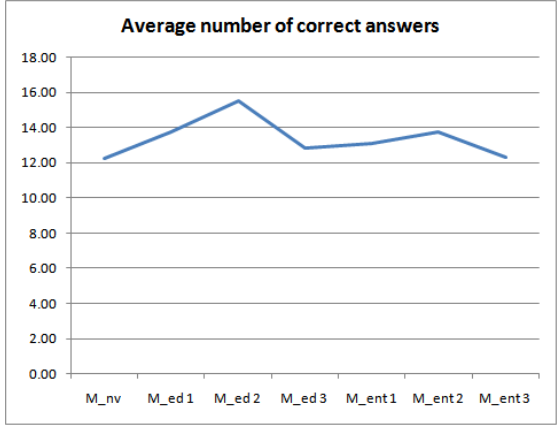
Figure 3. Illustration of average number of correct